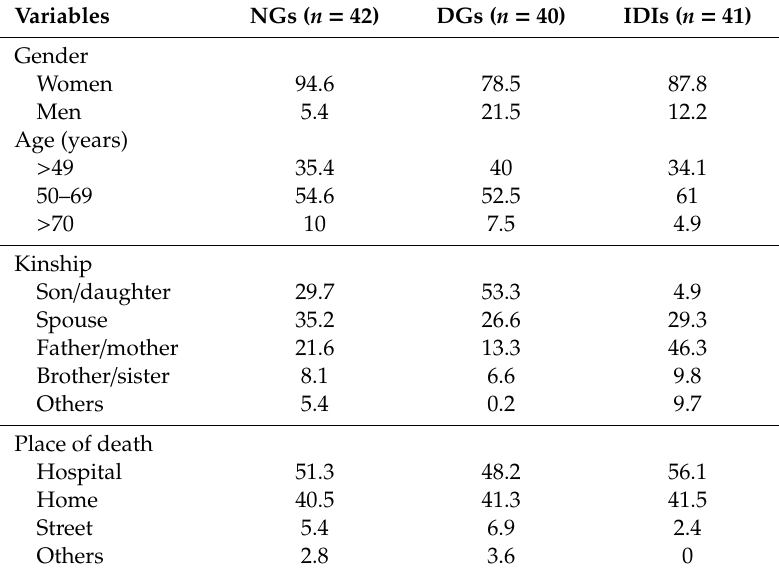
Table 2. Sociodemographic characteristics of the participants (%).